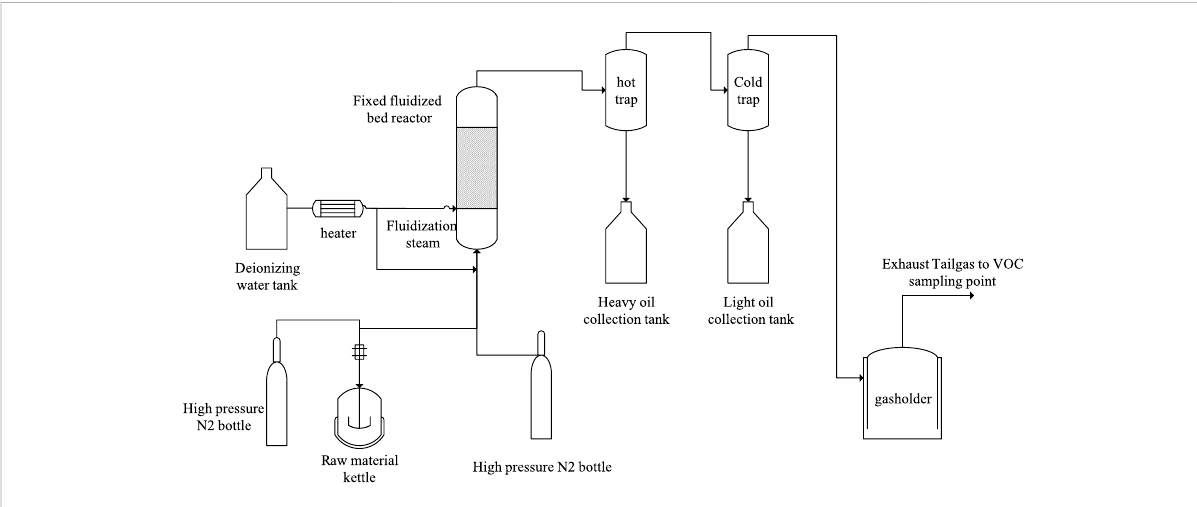
FIGURE 1 Flow diagram of the fl uidized bed pyrolysis experimental apparatus. Bo Tian, female, (1981-), PhD, permanent resident of South Africa, Native place: Jiuquan, Gansu Province, Professoriate senior engineer, Technology development lead a n d senior Project technical leader, Fluidized